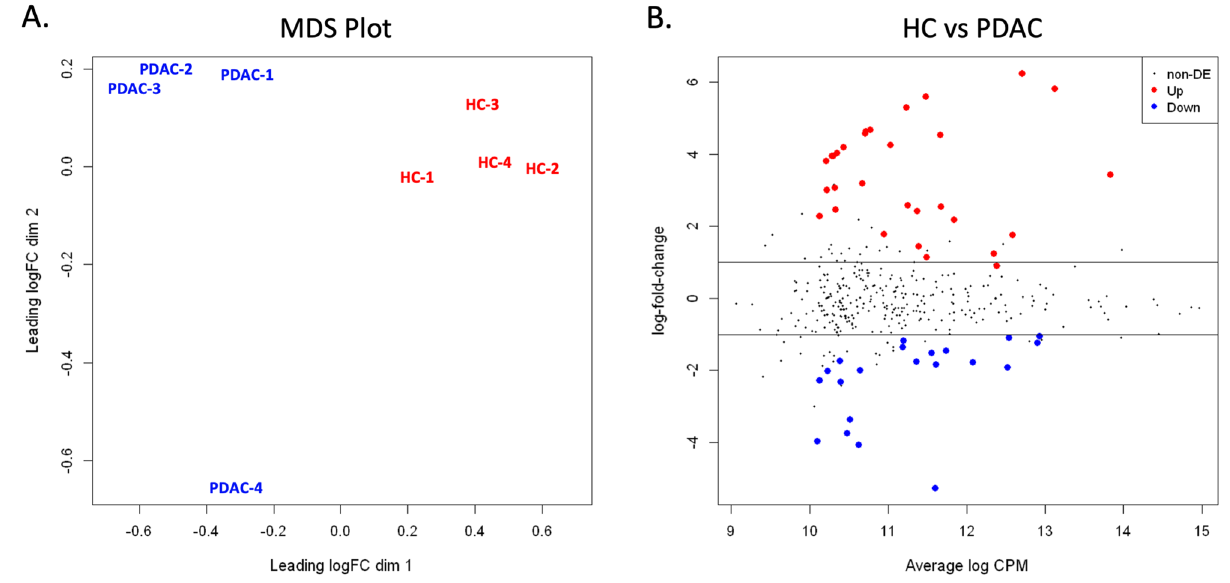
Figure 3. Statistical comparison of proteins identified in EVs isolated from healthy control (HC) and PDAC pancreatic organoids. ( A ) Multidimensional scaling (MDS) demonstrates clustering of samples by condition (HC versus PDAC) with PDAC-4 further removed from other PDAC samples. ( B ) Distribution of the candidate proteins with significant change (Up or Down) or without differential expression (non-DE) between the HC and PDAC sample sets are visualized by plotting fold change vs CPM.